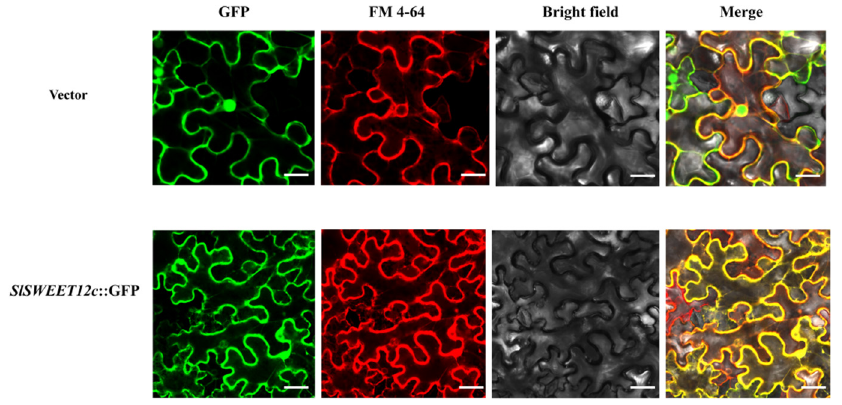
Figure 3. Subcellular localization of SlSWEET12c in tobacco leaves. FM4-64 was used as a positive control. Scale bars correspond to 25 μ m. Results are representative of experiments repeated at least three times.